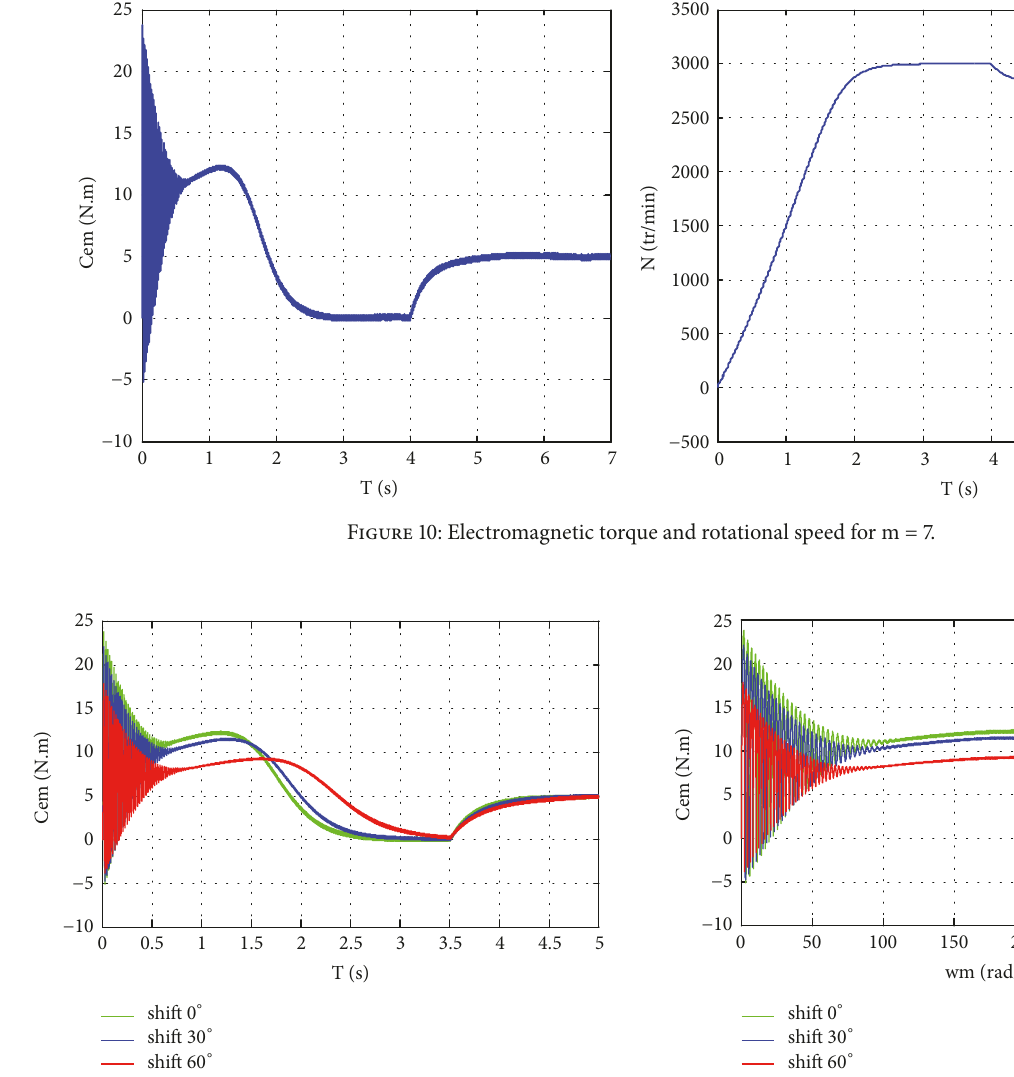
Figure 11: Characteristic electromagnetic torque.